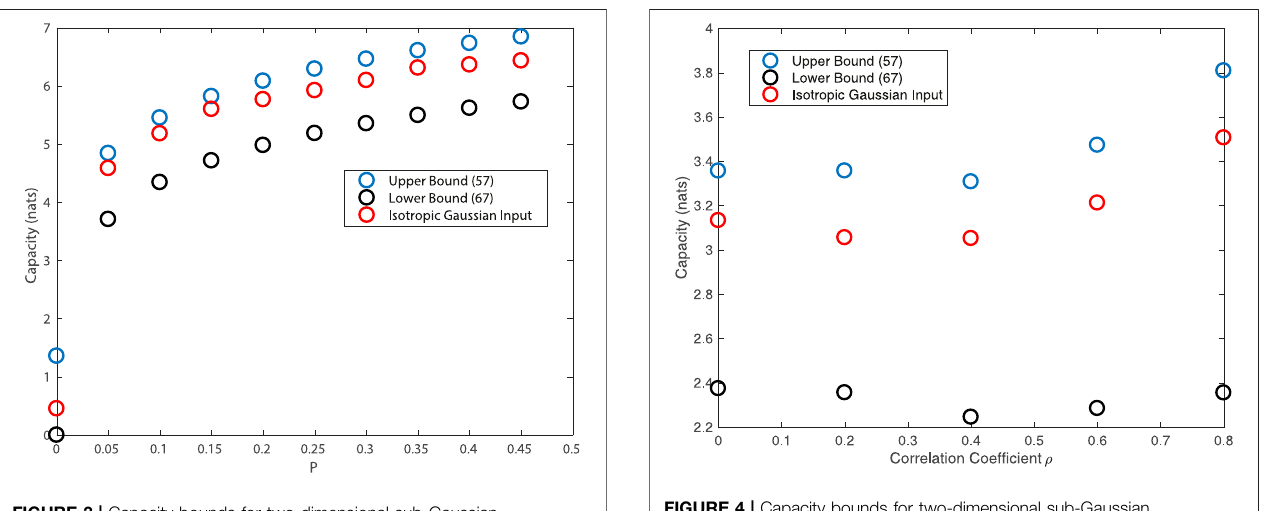
FIGURE 3 | Capacity bounds for two-dimensional sub-Gaussian α -stablenoisechannelssubjecttoapowerconstraint P ,with Σ givenin Eq.72 and α (cid:3) 1.2.